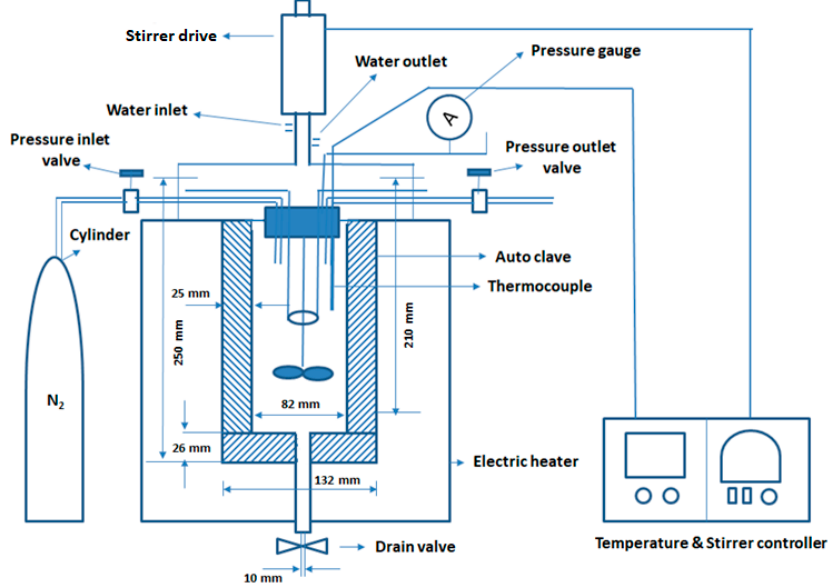
Figure 1. Schematic of the laboratory scale batch HTL reactor.